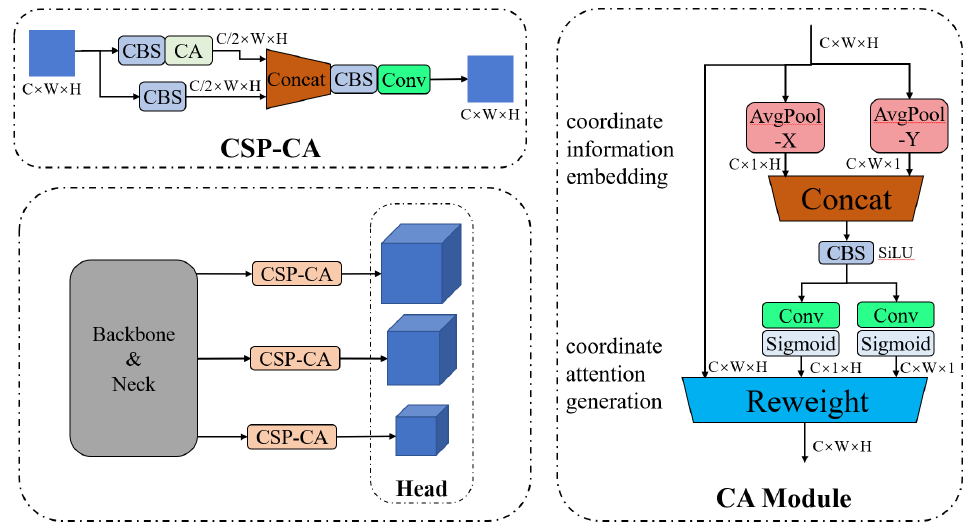
Figure 4. Structure of CSP-CA